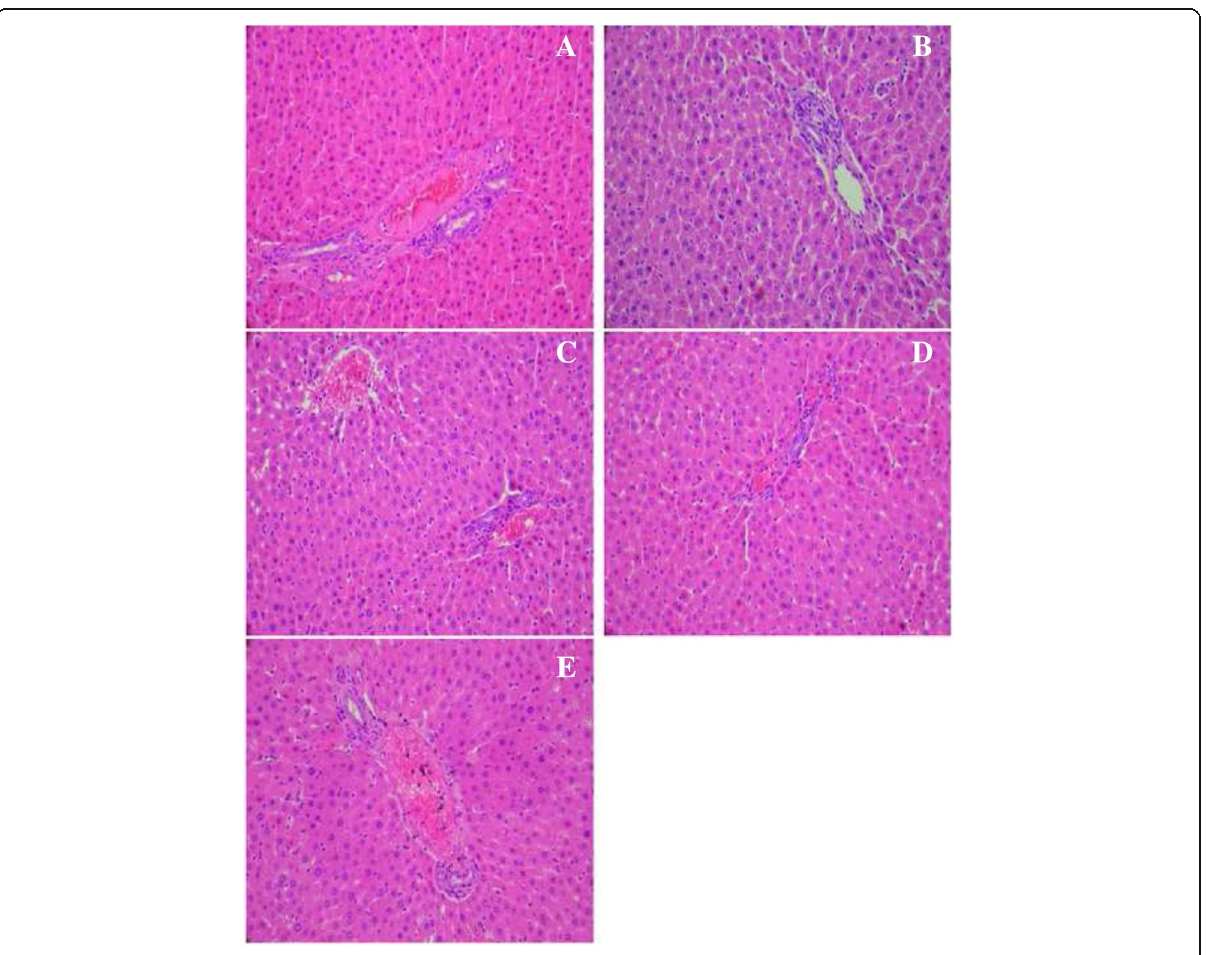
Fig. 7 Histopathological studies of liver in experimental groups of rats. a Section of the liver from a control rat showing normal architecture; ( b ) alloxan-diabetic rat showing lymphocyte infiltration and a moderate vacuolation of hepatocytes of hepatic cells ( c - d ); alloxan-diabetic rat treated with the ethanol extract from leaves of C. scolymus at a doses of (200 mg/kg-400 mg/kg) and ( e ); alloxan-diabetic rat treated with acarbose, a protective action was shown (H&E ×